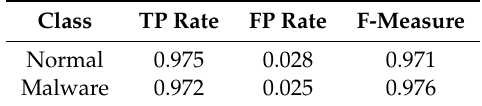
Table 10. Detailed accuracy of C5 decision tree on ADFA dataset.